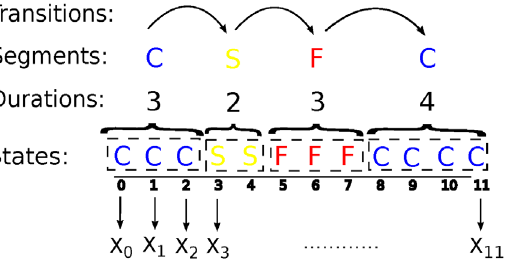
Figure 2. Schematic representation of a HSMM. At each step, an observed feature X is related to a state, which encodes a behavioural mode (C: cruising, F: fishing, S: searching). The state process is modelled at the segment scale and it is characterized by durations and transitions as shown above.